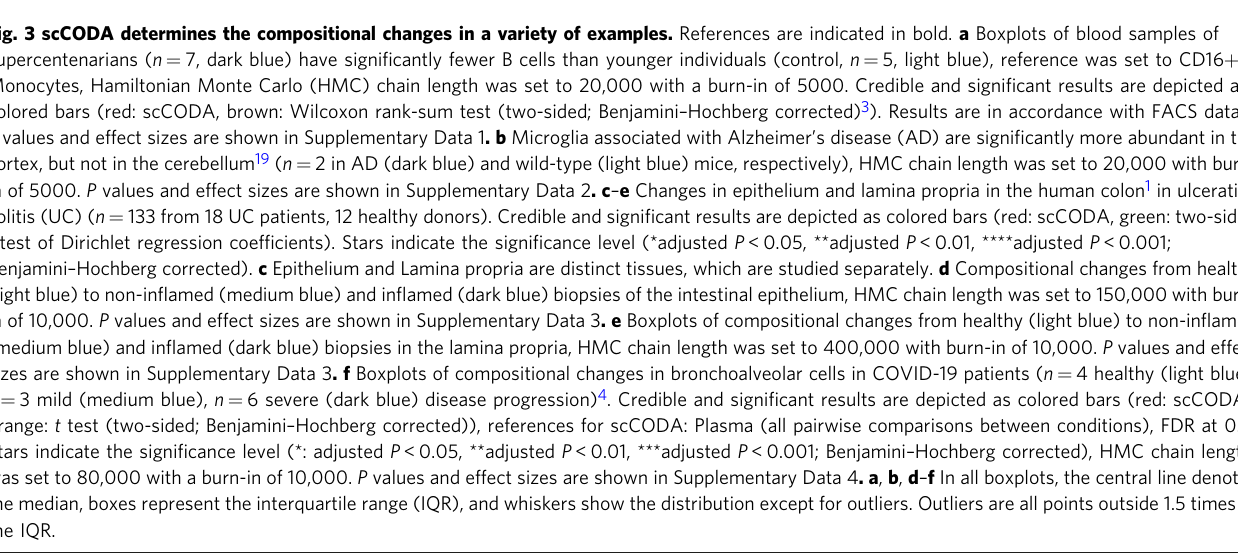
Fig. 3 scCODA determines the compositional changes in a variety of examples. References are indicated in bold. a Boxplots of blood samples of supercentenarians ( n = 7, dark blue) have signi fi cantly fewer B cells than younger individuals (control, n = 5, light blue), reference was set to CD16 + Monocytes, Hamiltonian Monte Carlo (HMC) chain length was set to 20,000 with a burn-in of 5000. Credible and signi fi cant results are depicted as colored bars (red: scCODA, brown: Wilcoxon rank-sum test (two-sided; Benjamini – Hochberg corrected) 3 ). Results are in accordance with FACS data 3 . P values and effect sizes are shown in Supplementary Data 1 . b Microglia associated with Alzheimer ’ s disease (AD) are signi fi cantly more abundant in the cortex, but not in the cerebellum 19 ( n = 2 in AD (dark blue) and wild-type (light blue) mice, respectively), HMC chain length was set to 20,000 with burn- in of 5000. P values and effect sizes are shown in Supplementary Data 2 . c – e Changes in epithelium and lamina propria in the human colon 1 in ulcerative colitis (UC) ( n = 133 from 18 UC patients, 12 healthy donors). Credible and signi fi cant results are depicted as colored bars (red: scCODA, green: